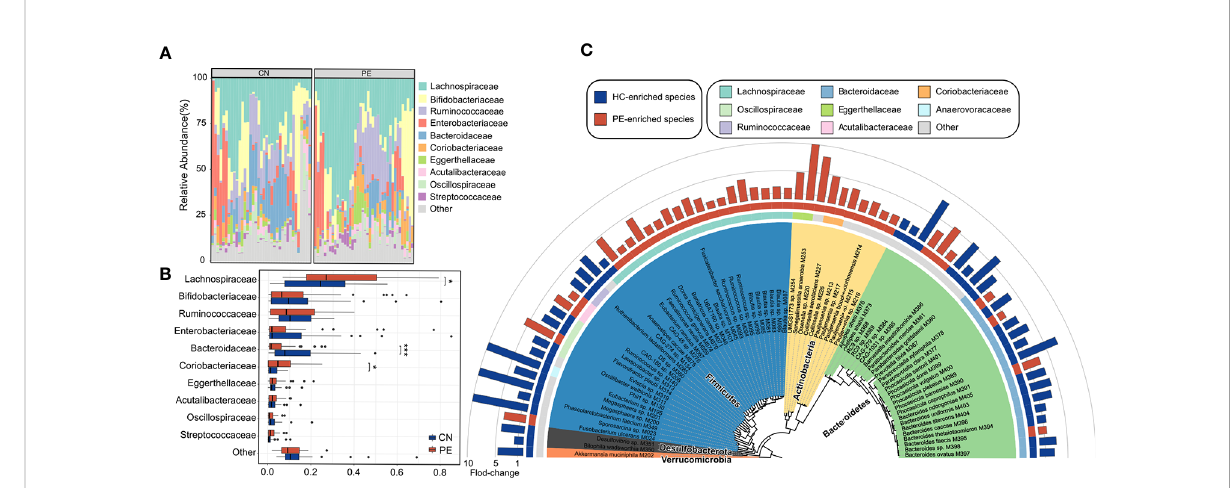
FIGURE 3 Family- and species-level alteration of the gut microbiota in PE patients. (A) Composition of gut microbiota at the family level. (B) Boxplot shows the dominant families of the gut microbiota when compared between the PE patients and healthy controls. (C) Detailed information of 74 species that differed in abundance between the gut microbiota of PE patients and healthy controls. Innermost circle, phylogenetic tree analysis of 74 PE-associated species based on their genome sequences. The colors in the tree indicate the phylum-level taxonomic assignment of the species. Circle 2: taxonomic assignment of the species at the family level. Circle 3: enrichment direction of the species. Red and blue label the species that enriched in the PE patients and controls, respectively. Outermost circle: barplot shows the fold changes of species abundance in PE patients compared with that in healthy